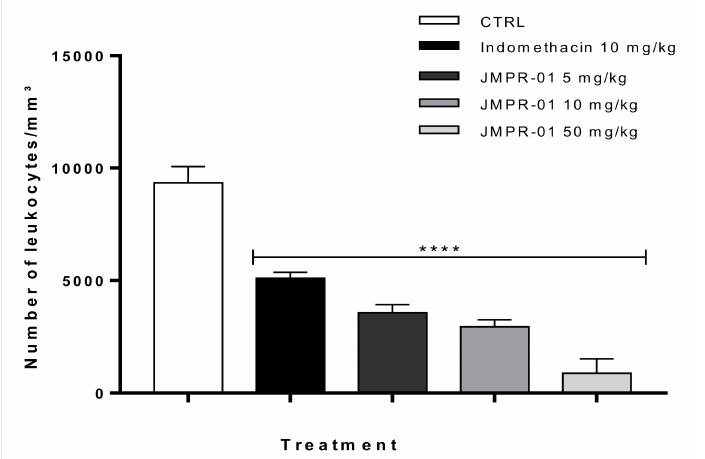
Figure 4. Influence of JMPR-01 (5, 10 and 50 mg/kg) treatment on total leukocyte count in the peritonitis induced by zymosan. Data are expressed as means ± SEMs; n = 6 mice per group. Two- way ANOVA followed by the Bonferroni’s test. **** ( p < 0.0001) significantly different from the control